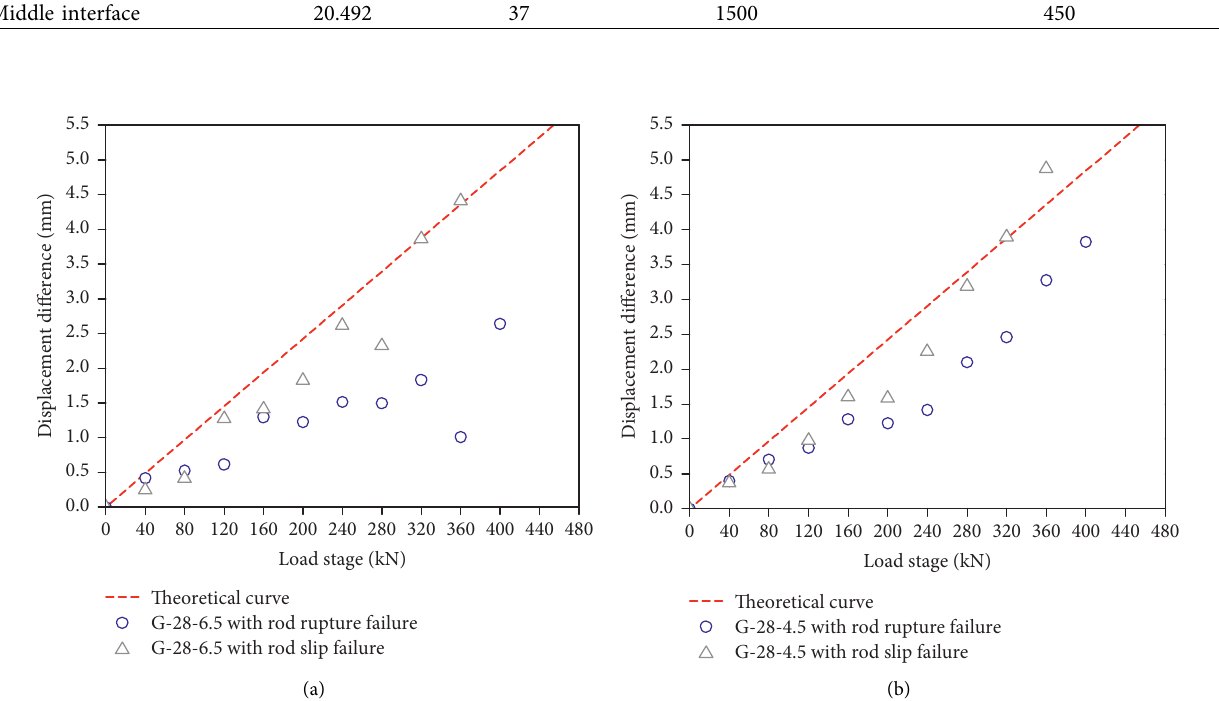
Figure 25: Comparison of the theoretical curve and experimental results for the load-displacement difference relationship: (a) G-28-6.5 and (b) G-28-4.5.